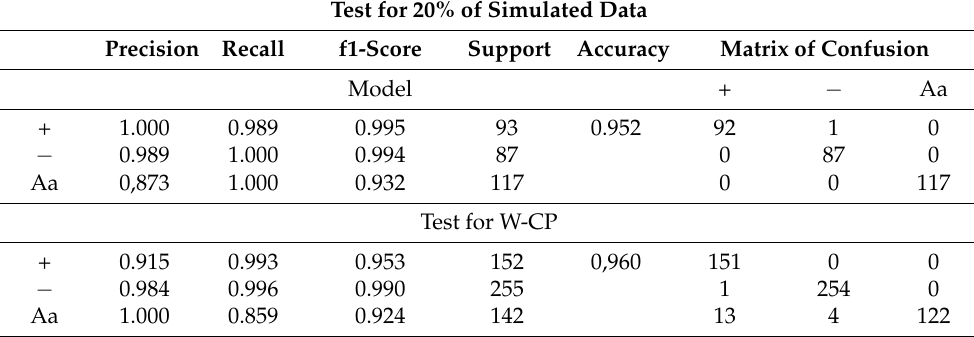
Table 3. Confusion matrix and evaluation criteria for the random forest classifier (RFC) model of the S-Data-model. Test for 20% of Simulated Data